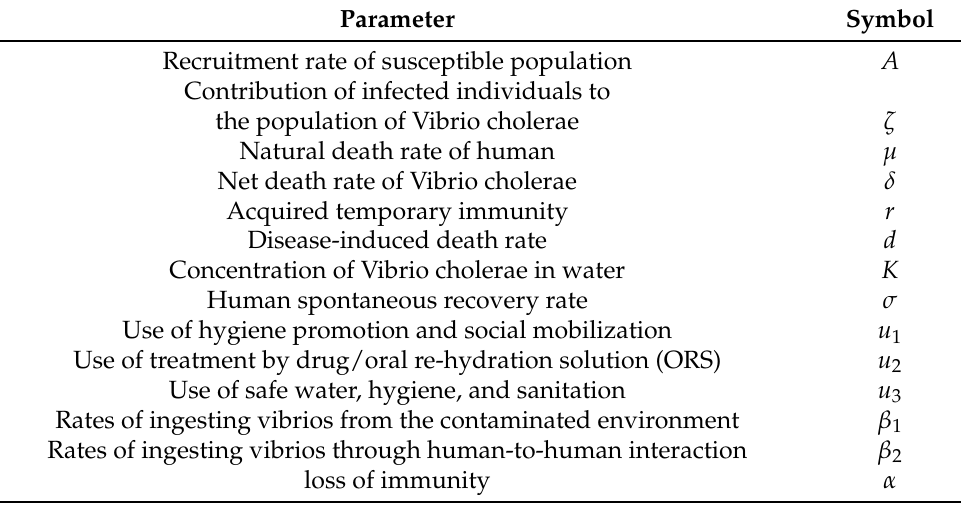
Table 2. Descriptions of cholera control model